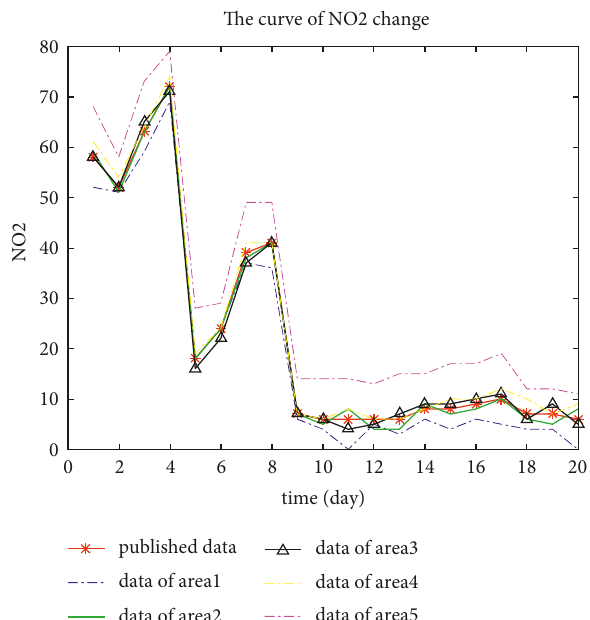
Figure 9: Curve of NO 2 change in different task grid areas.